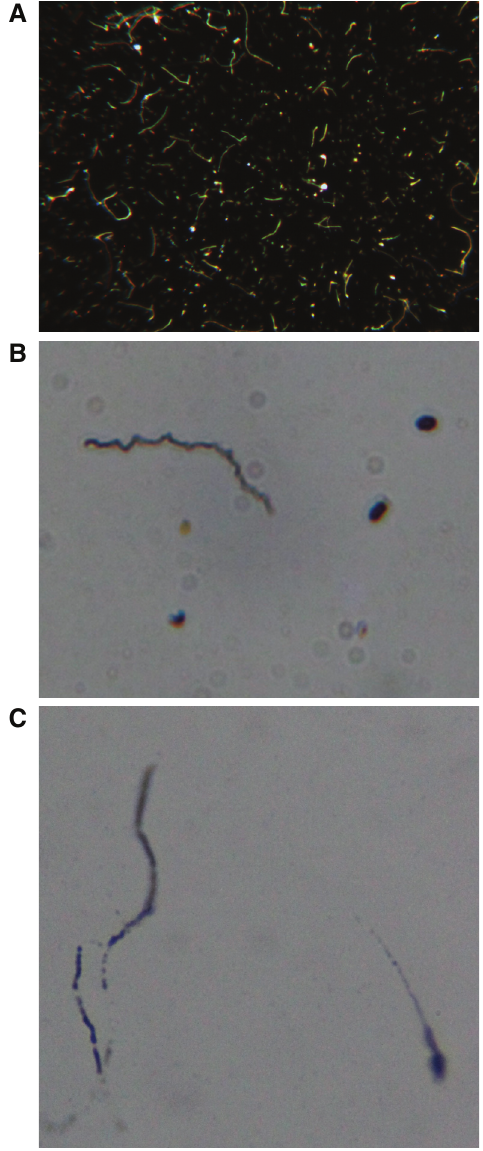
Figure 1. A : Darkfield image of genital culture from Patient 1. Note numerous spirochetes. 400× magnification. See Dataset, data file 1. B : Dieterle silver stain of genital culture from Patient 12. Note darkly staining spirochete. Formalin fixed slide, 400× magnification. See Dataset, data file 2. C : Semen sample from Patient 10 showing B. burgdorferi spirochetes (left) and sperm cell (right). Dieterle silver stain of acetone fixed slide, 1000× magnification. See Dataset, data file 2.